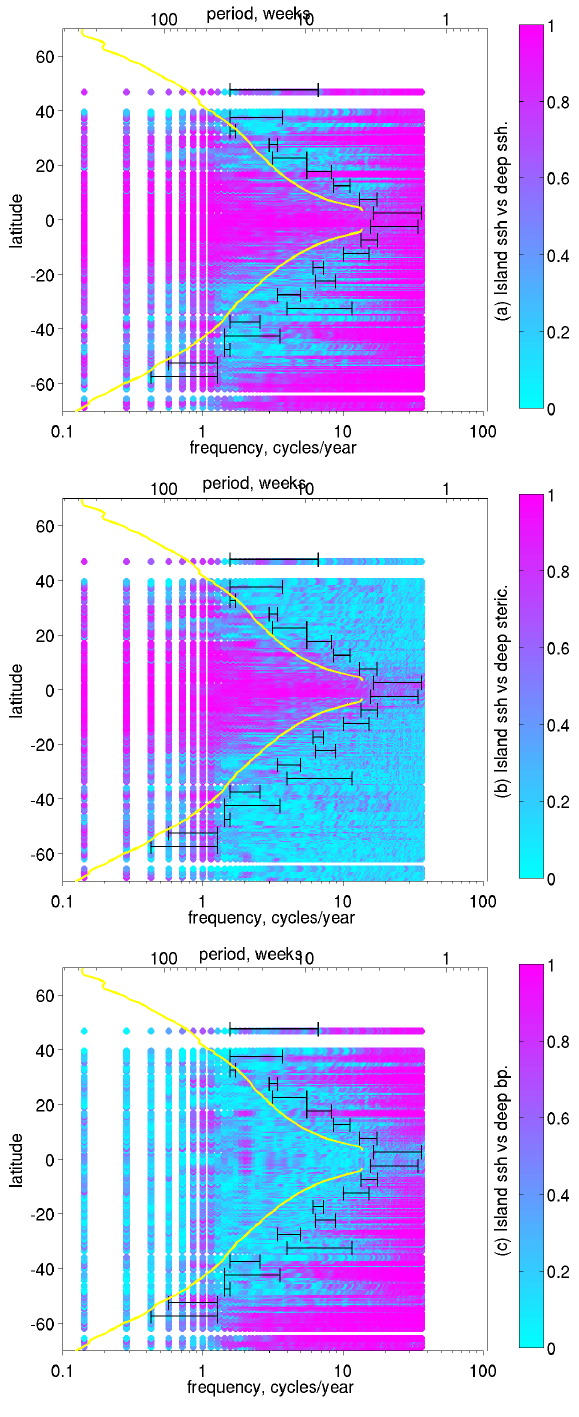
Fig. 6. Magnitude squared coherence of sea-surface height at island and (top to bottom) (a) sea-surface height ( h ), (b) steric height ( φ ), and (c) bottom pressure ( p ), in deep water nearby, for every island by latitude and frequency. Pink dots indicate a high coherence and blue low. Black bars emphasize the transition region between domi- nance of γ hφ and γ hp . Linear baroclinic Rossby waves are possible only to the left of the yellow